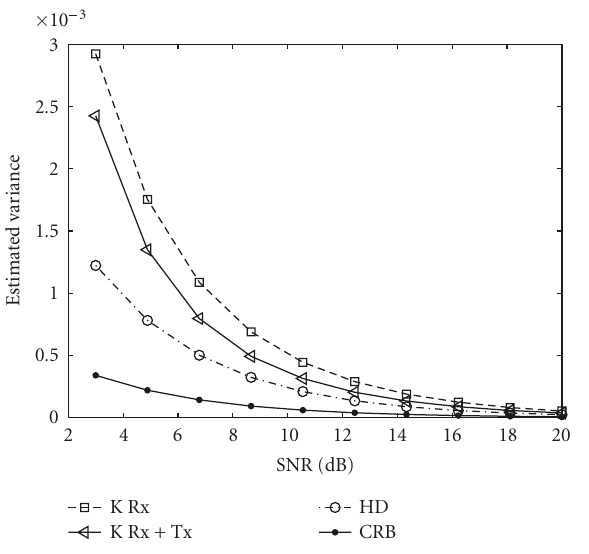
Figure 5: Estimated variance for the estimate of the position of tar- get 2 versus SNR corresponding to the location under significant multiple scattering conditions of two targets located at X 1 = ( X 1 = − 1, Y = − 6) and X = ( X = 1, Y = − 6). The di ff erent plots cor- 1 2 2 2 respond to the receive-mode time-reversal MUSIC method (K Rx), the transmit-plus-receive time-reversal MUSIC method (K Rx+Tx), the high-dimensional method (HD), and the CRB. The search was done on the X coordinate only, the Y coordinate being fixed during the simulations at the correct value.